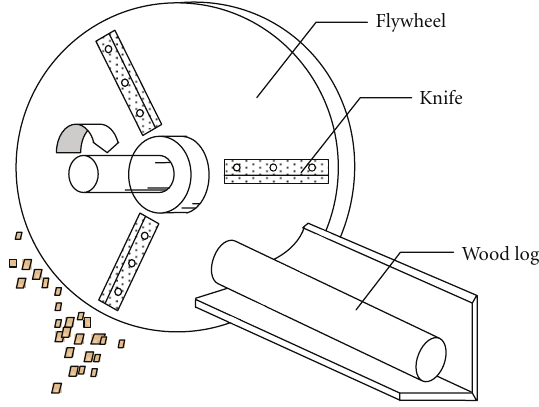
Figure 2: Illustration of a disk chipper (after [4]).